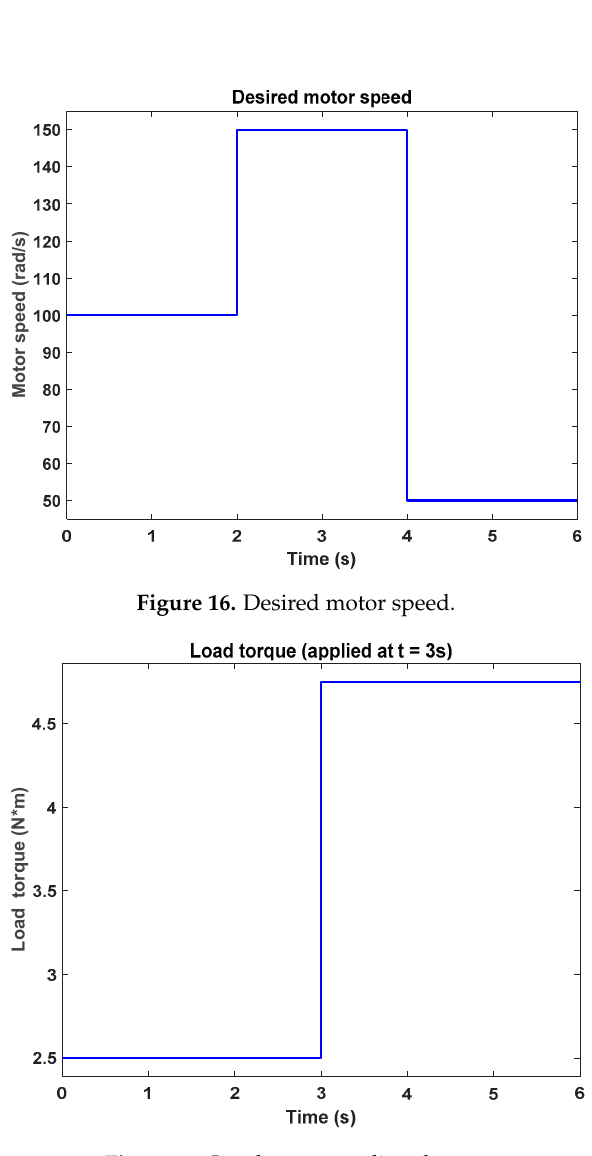
Figure 17. Load torque as disturbance.